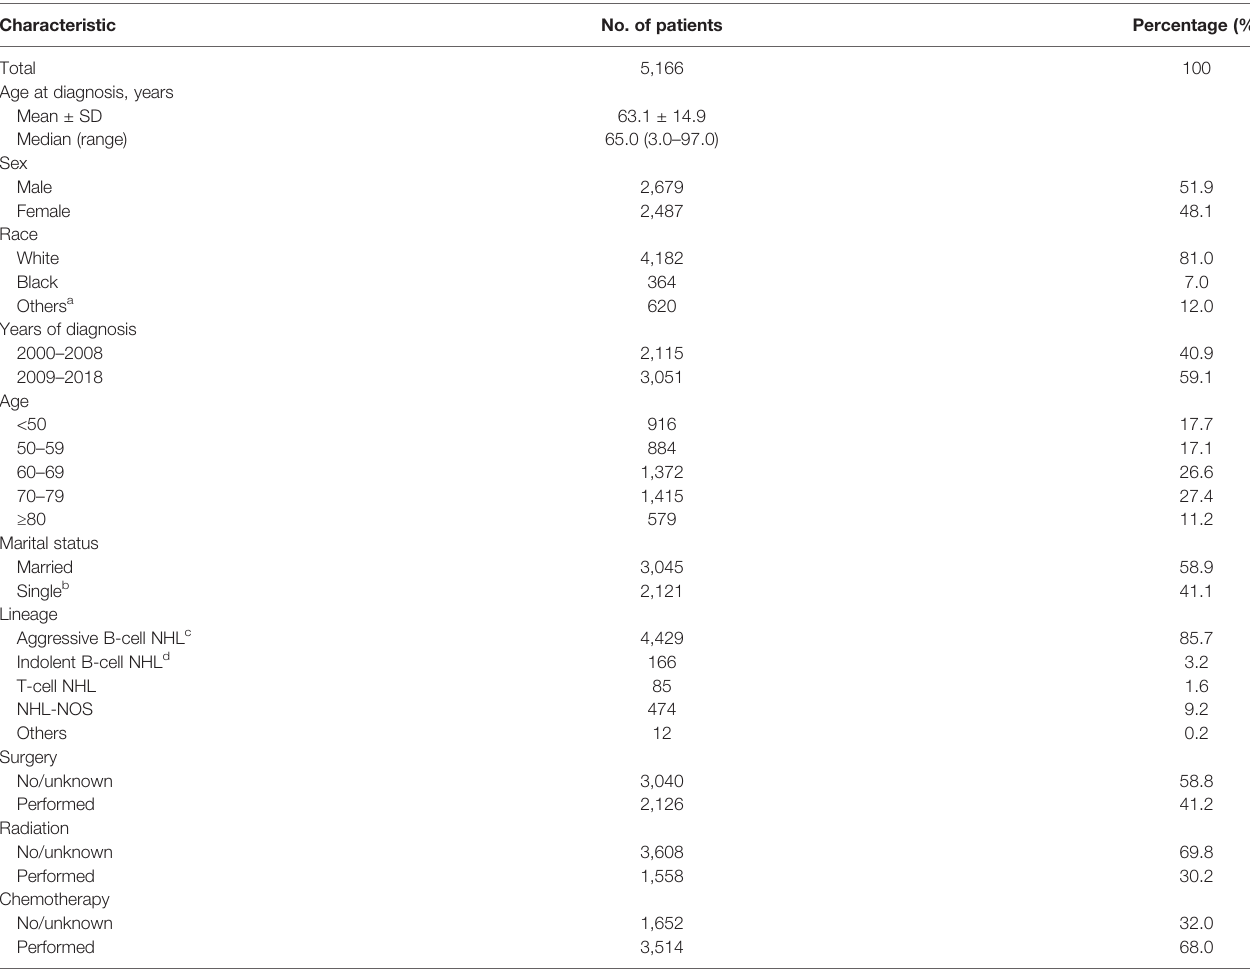
TABLE 1 | Patient and tumor characteristics of primary central nervous system lymphoma diagnosed in SEER 18 registries, 2000 – 2018.